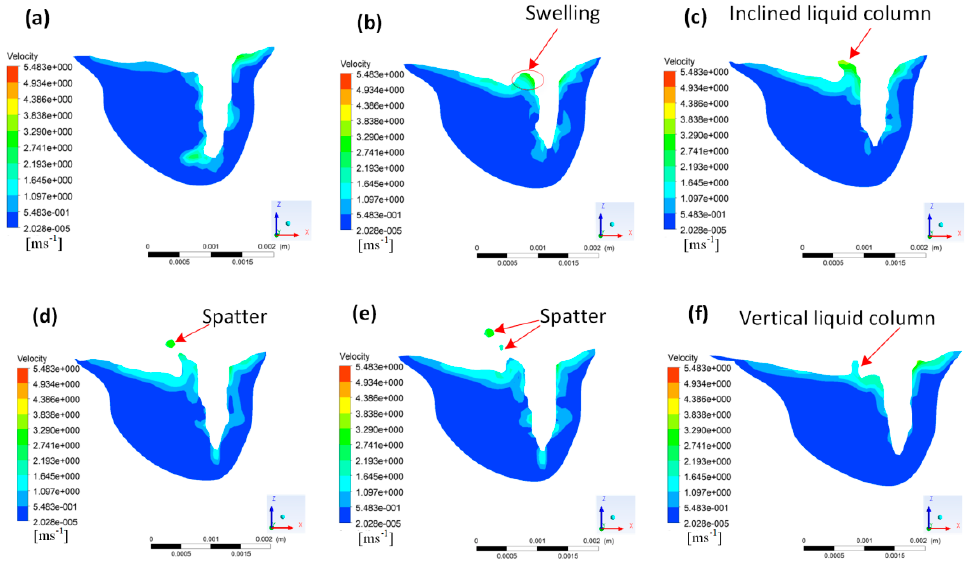
Figure 10. Velocity contour of the molten pool when the welding speed was 6 m/min: ( a ) t = 17 ms, ( b ) t = 18.1 ms, ( c ) t = 18.2 ms, ( d ) t = 18.3 ms, ( e ) t = 18.4 ms, ( f ) t = 18.5